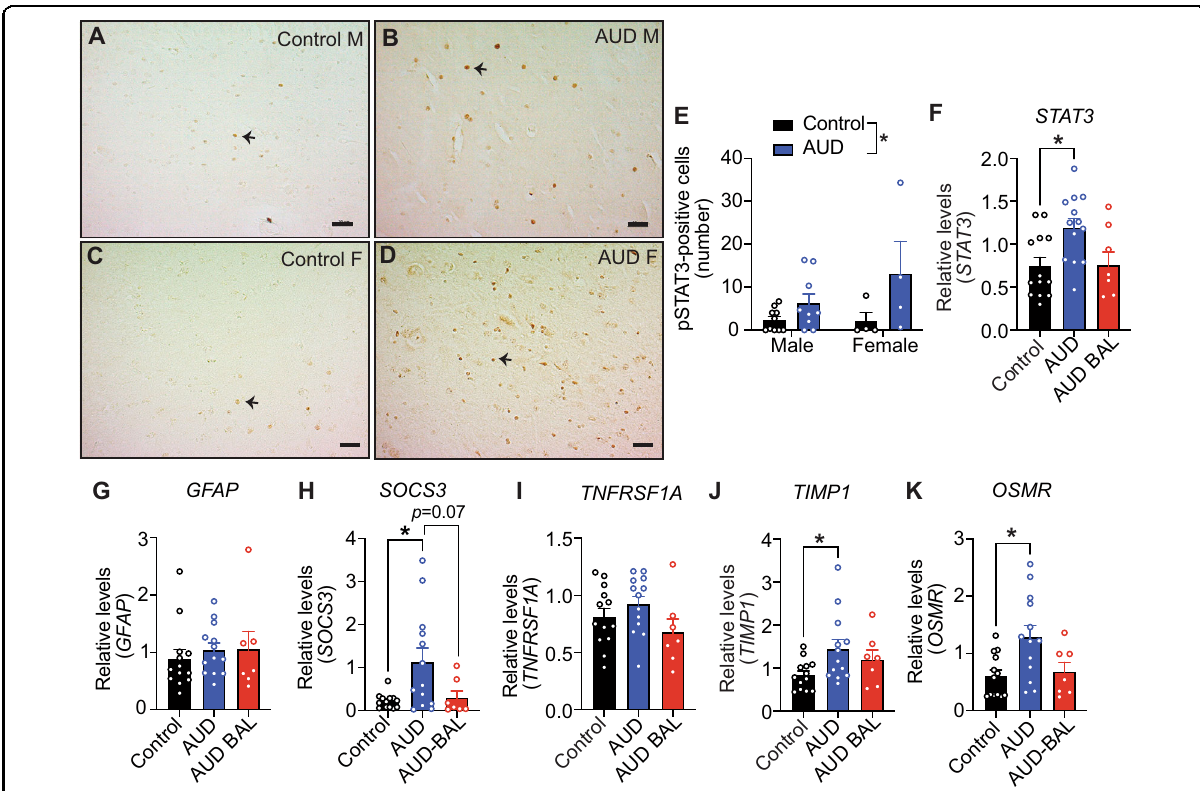
Fig. 5 Increased phosphorylated (p)STAT3 and expression of STAT3 target genes in the postmortem hippocampus of human subjects with AUD. A – D Representative hippocampal sections showing immunohistochemistry with a pSTAT3 antibody (brown spots) from ( A , C ) control and ( B , D ) AUD subjects. Arrows point to examples of nuclei positive for pSTAT3. Scale bar, 50 μ m. M male, F female. E Quanti fi cation of pSTAT3-positive cells in control and AUD subjects. Data are presented as the mean ± SEM, n = 10 males per group and 4 females per group. * p < 0.05 main effect of condition by two-way ANOVA ( F (1, 23) = 6.7, p = 0.016). F – K Relative expression of F STAT3 , G GFAP , H SOCS3 , I TNFRSF1A , J TIMP1 , and K OSMR by qPCR in human postmortem hippocampus of control ( n = 13), AUD ( n = 13), and AUD subjects with blood alcohol levels at the time of death (AUD- BAL, n = 7). * p < 0.05 when compared to control by post hoc Tukey ’ s test after one-way